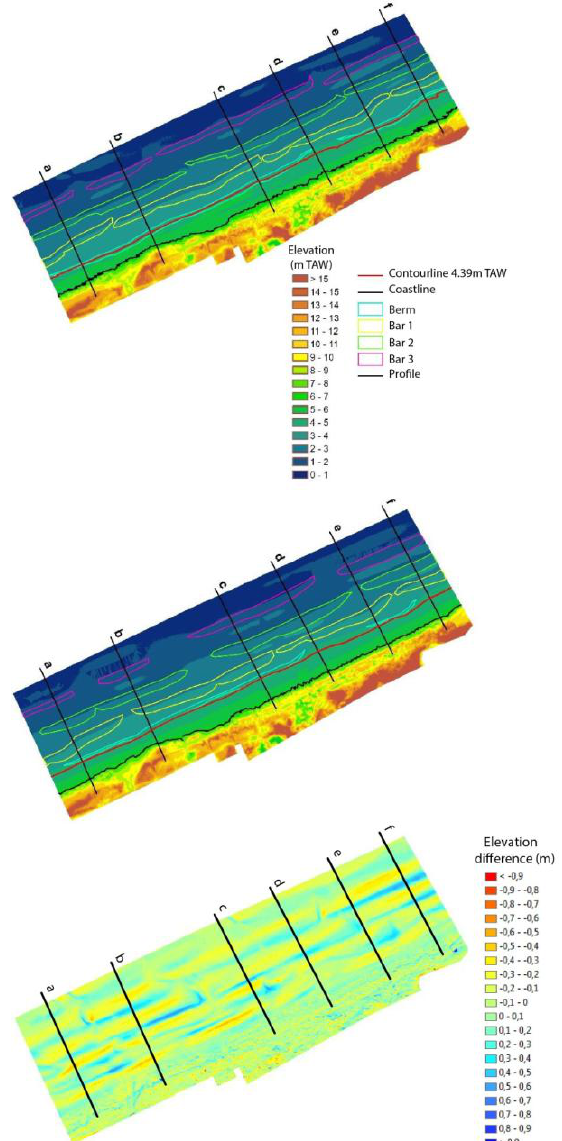
Figure 4. Extracted coastline indicators and beach morphological features superimposed on the DEMs of the pre- (14/12/2016) and post-storm (17/01/2017), and difference of DEMs.